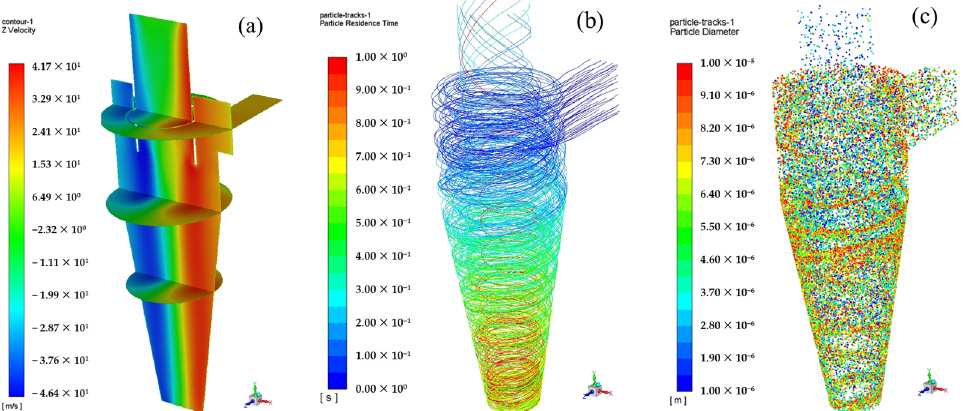
Figure 6. Simulation results (inlet wind velocity was 20 m/s): ( a ) Z-direction air flow velocity; ( b ) particle tracks by residence time; and ( c ) spatial distribution of dust particle diameter.